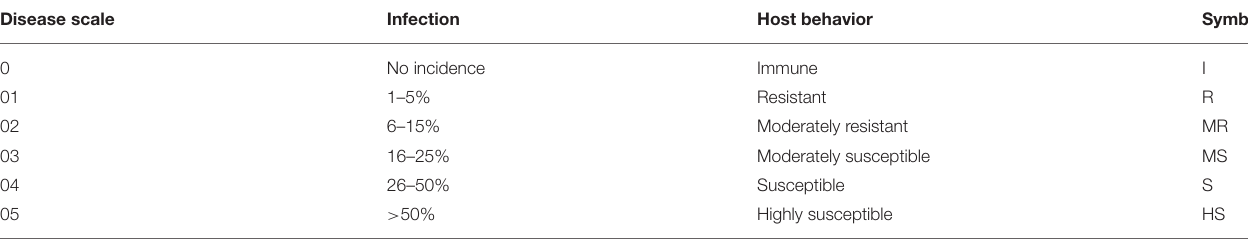
TABLE 1 | Disease rating scale for brown spot disease of rice. Disease